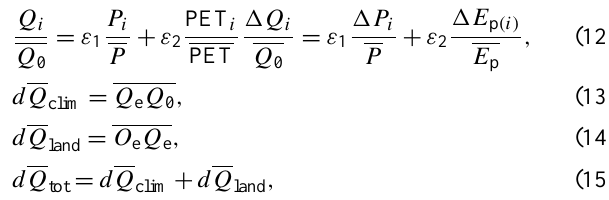
Figure 4. Evolution of streamflow ( Q ), precipitation ( P ), and po- tential evapotranspiration ( E p ) of the Miyun Reservoir catchment over 1961–2008. The dashed lines are the fitted linear trend for vari-